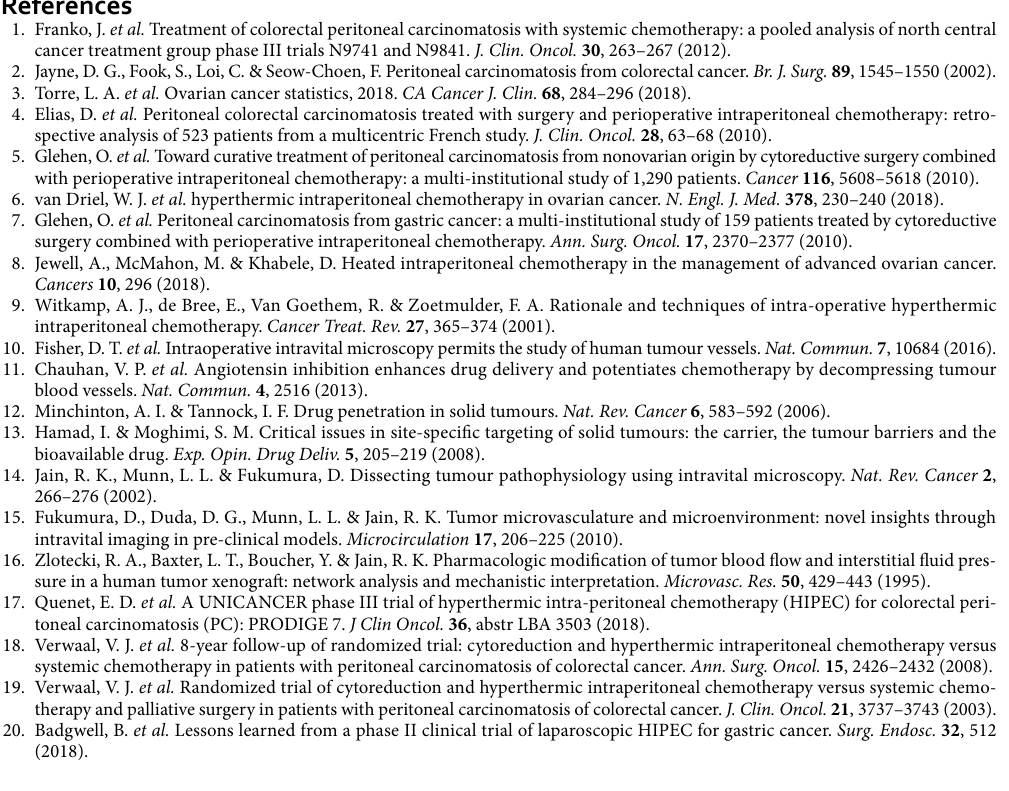
Table 2. Prior to the analysis, HIVM observations were de-identified to minimize bias. The number of observation fields (for both tumor and control areas) was recorded. Tumor-associated and control vessels were character- ized morphologically. A single vessel was described as beginning at a branch point and continuing to the next branch point. To be considered measurable, vessels had to be at least 100 μm in length with no branch points. Vessels were considered functional if fluorescein uptake was identified or if blood flow within the vessel could be visualized. In contrast, vessels were considered non-functional if there was no fluorescein uptake or no blood flow was visualized. Total numbers of functional and non-functional vessels were recorded. Vessel density (both functional and non-functional) was established by dividing the number of vessels by the number of fields of observation per area (control or tumor). The percentage of non-functional vessels per area (tumor or control) was calculated by dividing the number of non-functional vessels by the total number of vessels observed (# non- functional vessels / # non-functional vessels + # functional vessels) times 100. IC-Viewer software (Mauna Kea Technologies, Paris, France) was used to measure vessel diameter (d) at the vessel’s largest width. Blood flow velocity (v) was evaluated by determining the time that distinct features in an observed vessel would take to travel a known distance. Velocity was calculated by dividing the measured dis- tance by the time taken to travel that distance, and then averaging these values for at least 3 points per vessel. No velocities were calculated for non-functional vessels as by definition, these vessels did not support any blood flow. Statistical analyses. Demographic and clinical characteristics were summarized using the mean